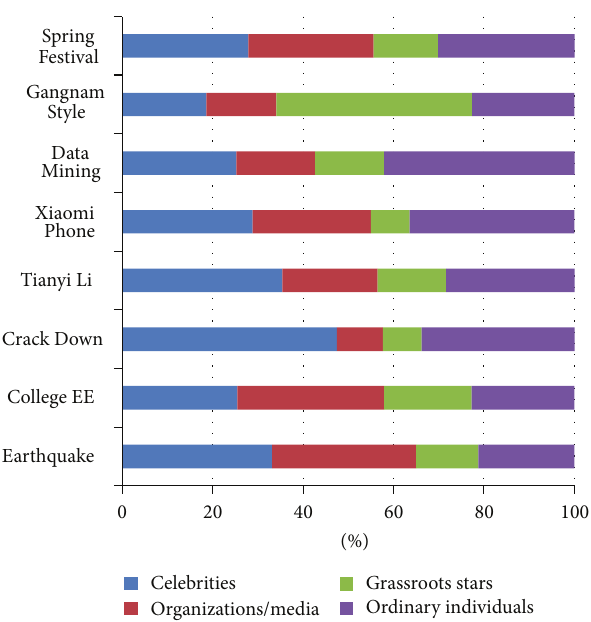
Figure 3: Posts size distribution on each